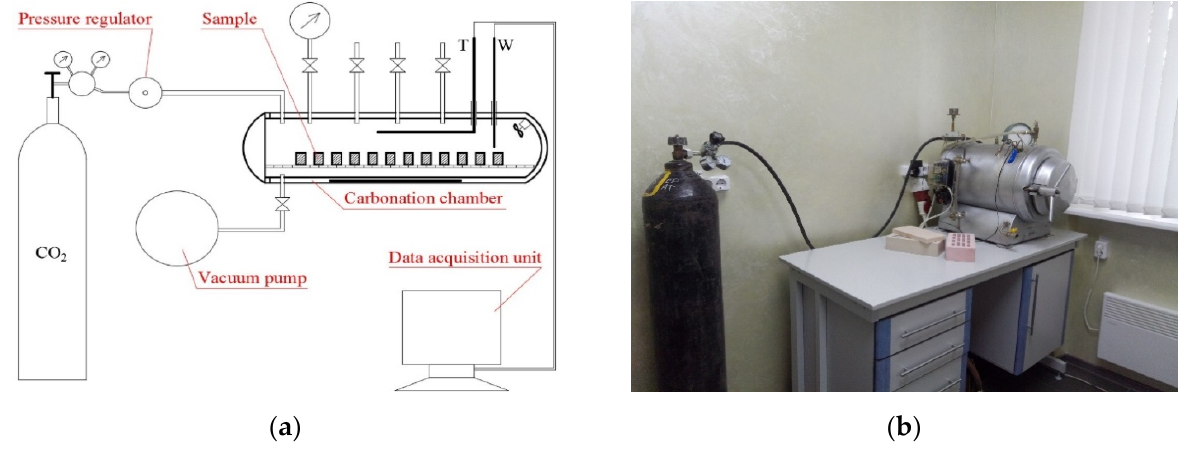
Figure 4. Block diagram ( a ) and general view ( b ) of the forced carbonisation chamber.